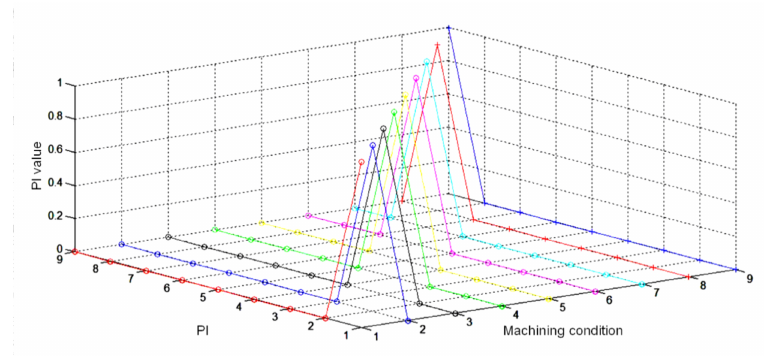
Figure 5. Fusion mechanism established by the backpropagation neural network (BPNN)